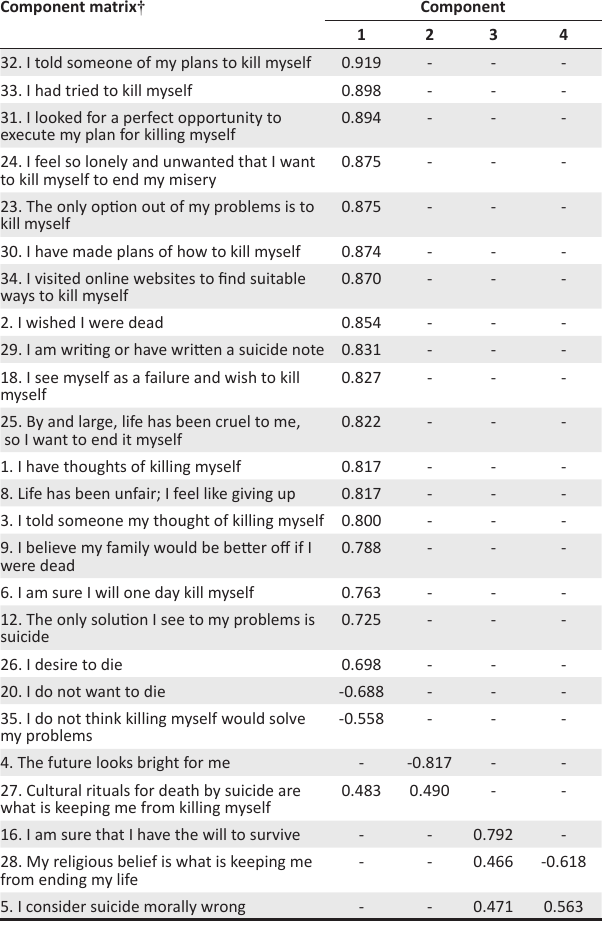
TABLE 3: Component matrix of 25 items of the Redeemer’s University Suicidality Scale. Component matrix †